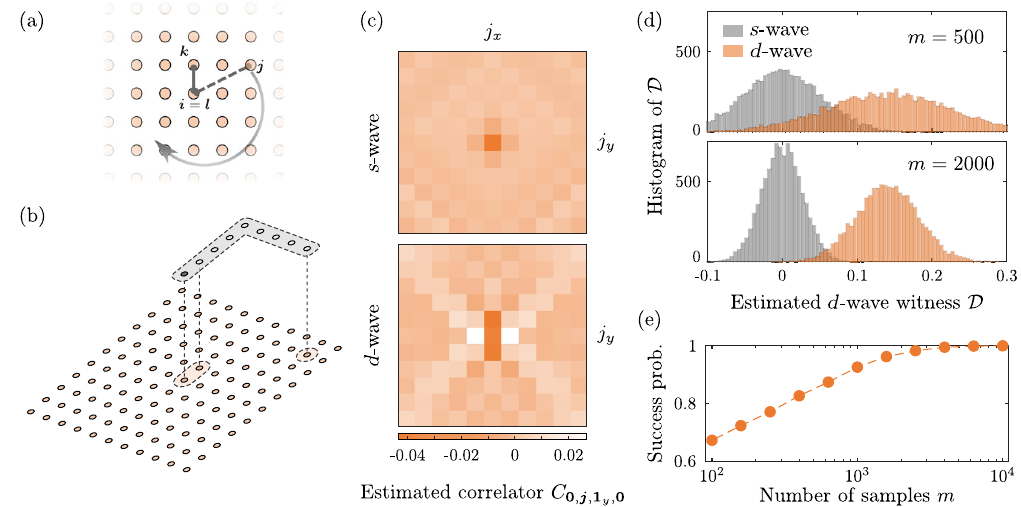
FIG. 7. Extraction of the superconducting pairing order parameter in a system of itinerant fermionic particles on a square optical ; j lattice, using our protocol. (a) We fix i , k , l and measure the correlator C i at different j ¼ ð j on the two-dimensional lattice ; j ; k ; l x y Þ (orange dots). In a d -wave superconductor, we expect C 0 to change signs as j (dashed line) rotates around 1 (solid line). (b) To ; j ; 1 y ; 0 y measure the correlators, we allow particles to tunnel vertically into the “ bridge ”— an ancillary one-dimensional lattice (gray dots) — that connects the support of C i . The bridge initially has two fermions, one for each spin orientation, both located at one of its ends ; j ; k ; l , each extracted using m ¼ 10 6 samples, reveal patterns consistent (denoted by the dark circle in the bridge). (c) The correlators C 0 ; j ; 1 y ; 0 with s -wave and d -wave pairing in the initial states. (d) The distribution for the estimates of the d -wave witness D [Eq. (61)] obtained using m ¼ 500 and m ¼ 2000 samples. We obtain the histograms by generating 10 4 independent sets of m samples and estimate D using each set. (e) The success probability in distinguishing s -wave and d -wave pairing using the witness D as a function of the number of samples m . We can distinguish between the s -wave (gray) and d -wave (orange) Ansätze with near-100% probability with only m ¼ 2000